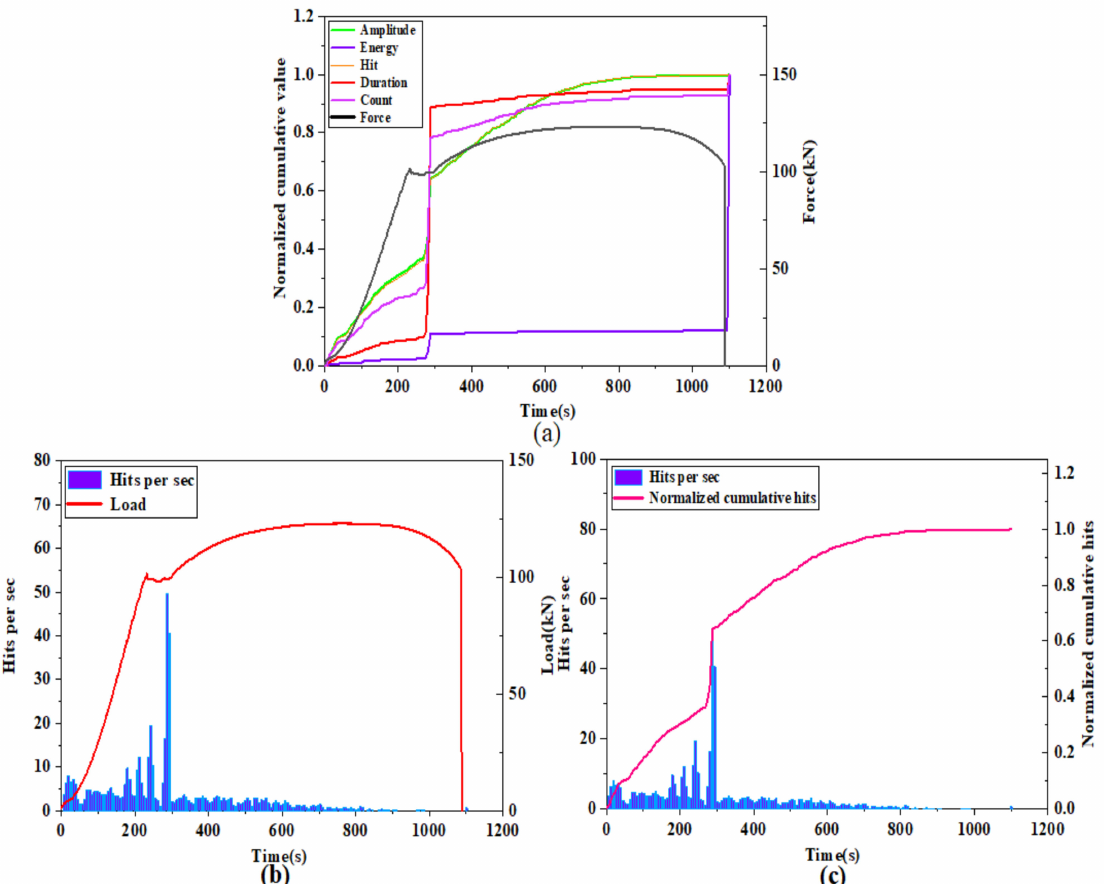
Figure 13. ( a ): change in normalized cumulative parameters during tensile damage; ( b ): change in number of hits per second and tensile force during tensile damage; ( c ): change in normalized cumulative number of hits and number of hits per second during tensile